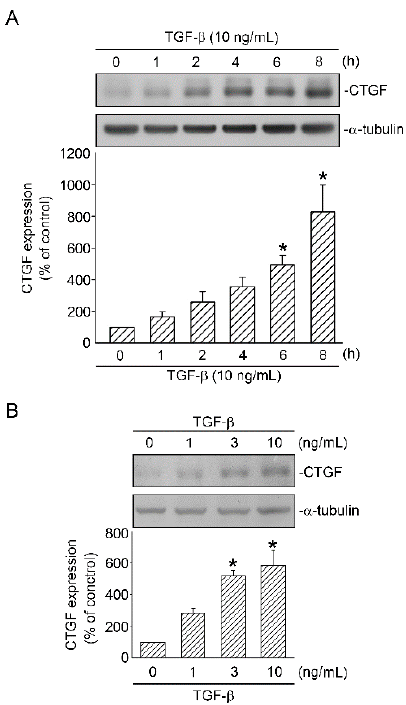
Figure 1. TGF- β -induced CTGF expression in human lung epithelial A549 cells. ( A ) A549 cells were treated with TGF- β (10 ng/mL) for 0–8 h. Cell lysates were prepared, and CTGF and α -tubulin antibodies were detected through Western blotting. Data are expressed as mean ± SEM of three independent experiments. * p < 0.05, compared with the control group without TGF- β stimulation. ( B ) Cells were stimulated with TGF- β (0–10 ng/mL) for 6 h. Cell lysates were prepared, and CTGF and α -tubulin antibodies were detected through Western blotting. Data are presented as mean ± SEM of three independent experiments. * p < 0.05, compared with the control group without TGF- β treatment.